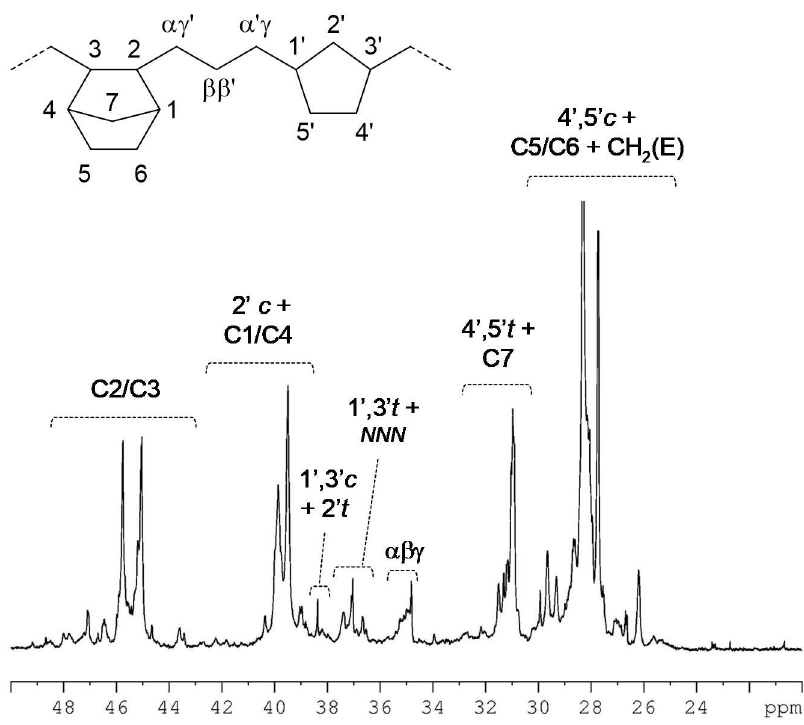
Figure 13. 13 C NMR spectrum (108.58 MHz, C 2 D 2 Cl 4 , 103 °C) of poly(E- ter- N- ter -HED) sample prepared by X/ MAO catalytic system at N/E/HED = 4/1/4.